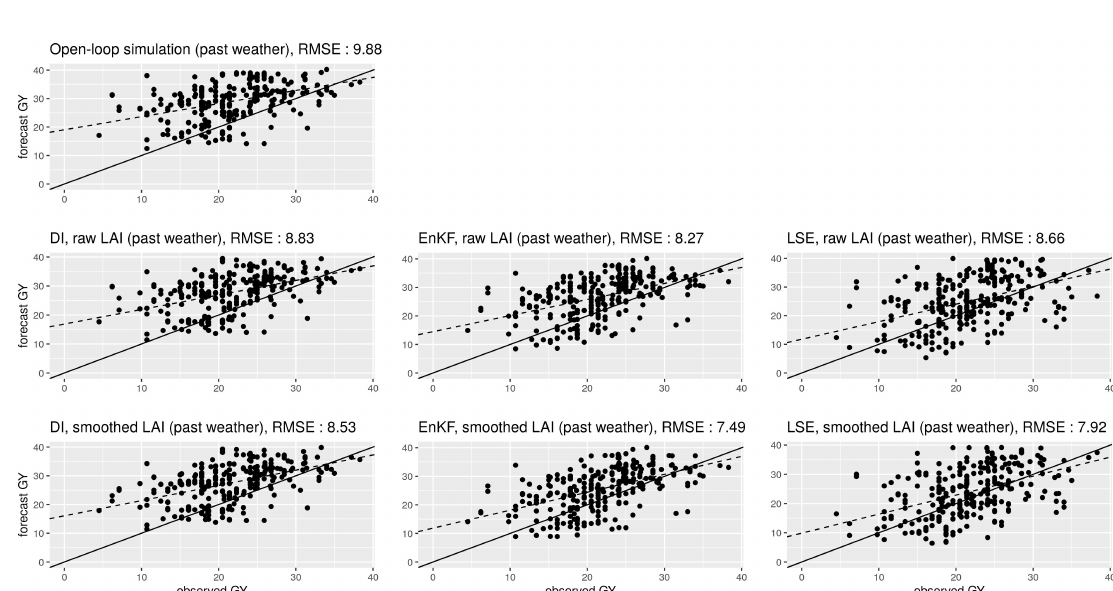
Figure 8. Forecast grain yields (GY) as a function of observed yield. Forecast and RMSE value for the open-loop simulation method (first line), the three assimilation methods (respectively DI, EnKF, LSE) based on raw LAI (second line) and the same three methods based on smoothed LAI (third line). The black solid line represents 1:1